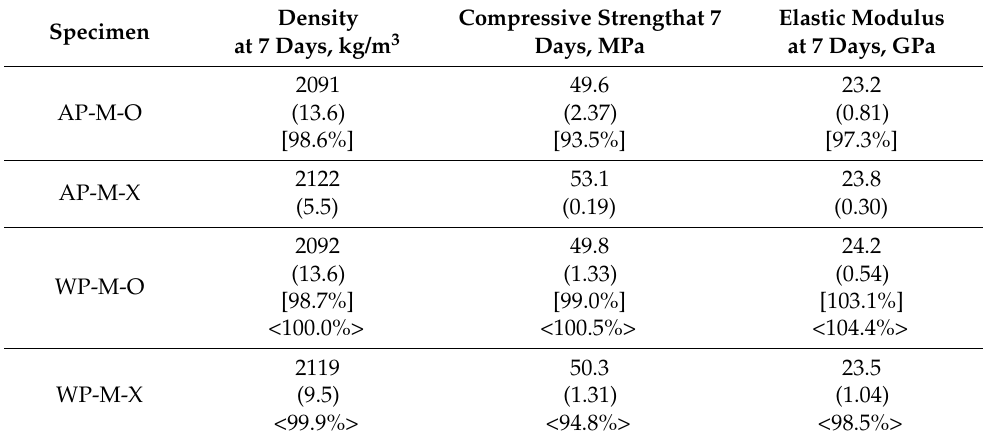
Table 3. Result of property evaluation according to whether specimens were compacted by a compaction rod or